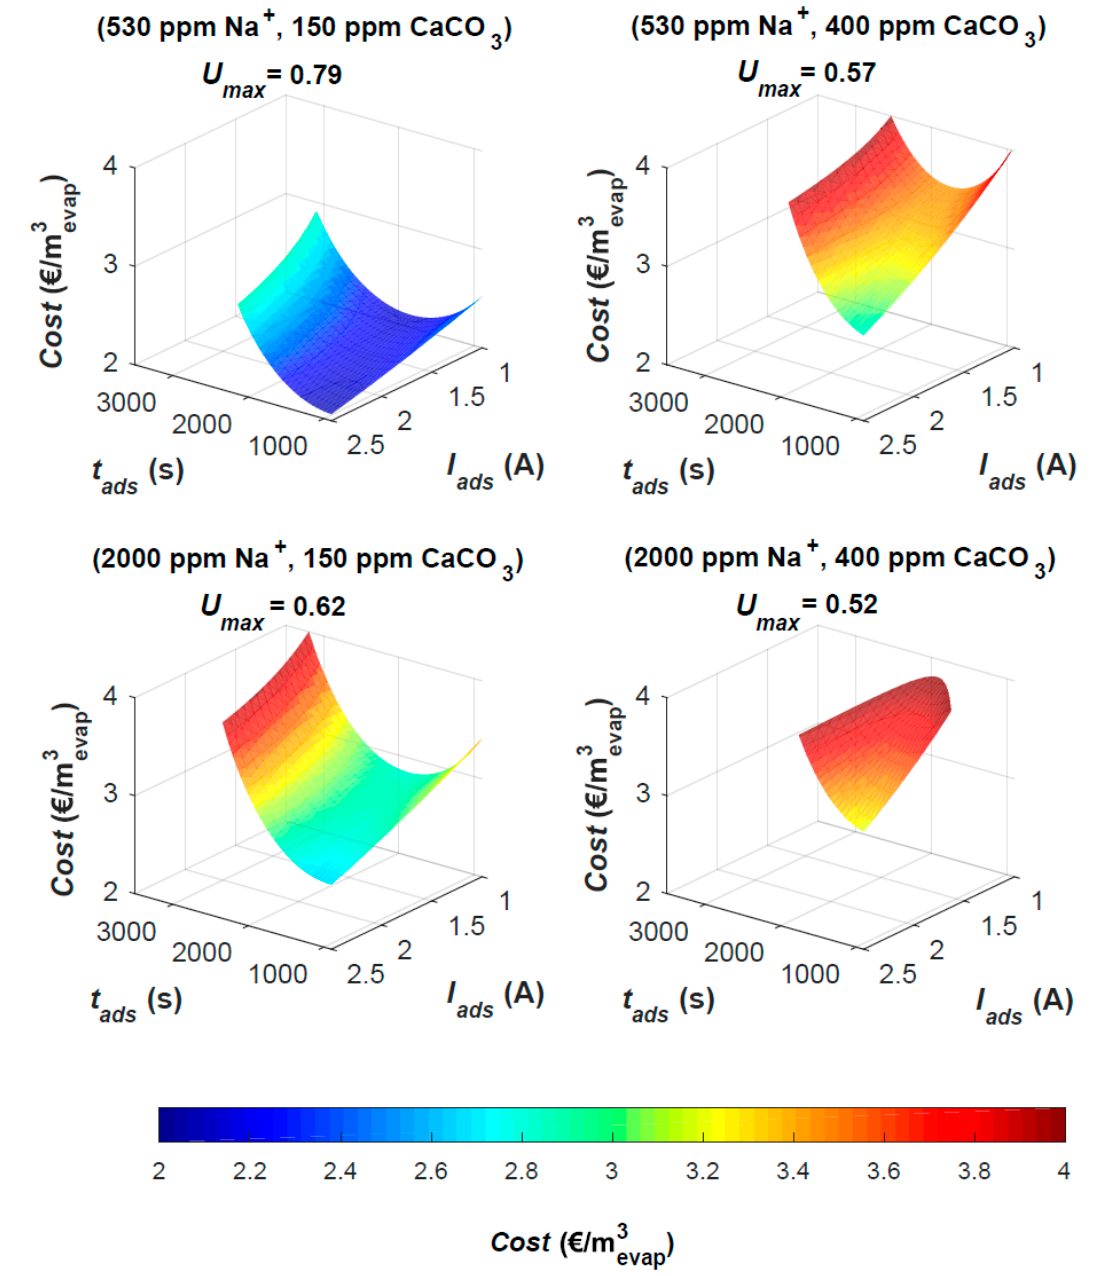
Figure 3. Cost ( € m − 3 evap. ) at maximal utilization ( U max ) versus current ( I ) and duration ( t ) of adsorption phase. For 4 distinct combinations of feed water composition ([Na + ], TH ), colormap indicates